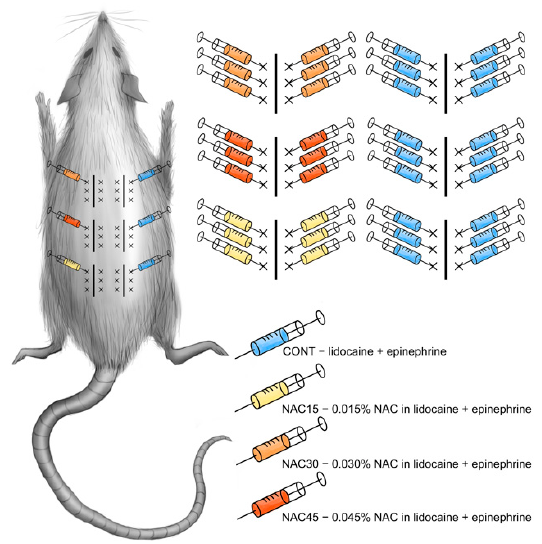
Figure 8. Diagram of incision lines and injection points on the rat’s dorsum. x—pre-incisional injection points of intradermal administration (0.1 mL). Straight line—marked incision line, 1.5 cm long. Two 4-0 mattress sutures were placed between the injection points of each wound. Sides (left and right) were randomly assigned to the control group (CONT) or exper- imental groups (NAC). One side received standard (control) solution of local anesthetic (0.5% lidocaine (Lignocainum Hydrochloricum WZF, Polfa Warsaw, Poland)) + vaso- constrictor (1:100,000 epinephrine (Adrenalina WZF, Polfa Warsaw, Poland)) 0.6 mL for each planned incision. The remaining side was treated with 3 concentrations of NAC (Acetylcysteine, Sandoz, Warsaw, Poland): 0.015%, NAC15 group, 0.03%, NAC30 group, and 0.045%, NAC45 group, dissolved in the same anesthetic solution as in the control group (0.5% lidocaine with 1:100,000 epinephrine), and randomly assigned to rostral, central, or caudal incisions.